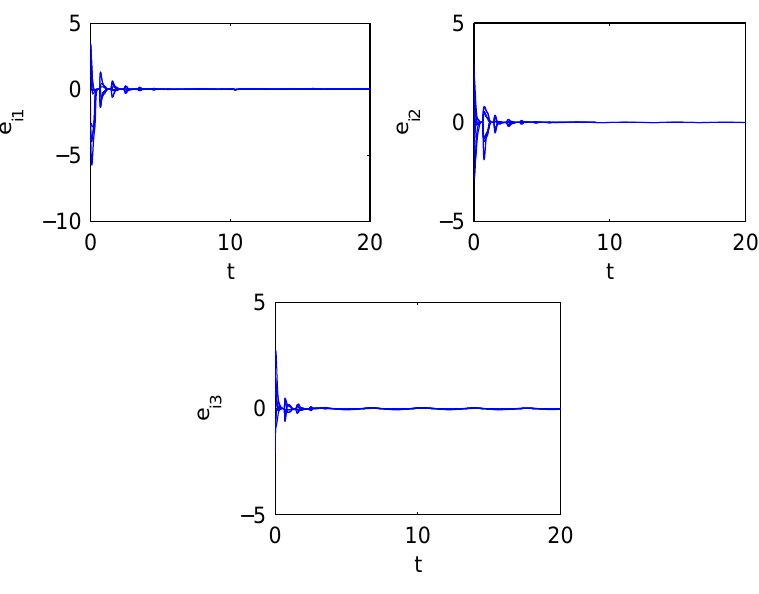
Figure 1. The errors between the cell output and synchronous output, with a chaotic Chua system being a